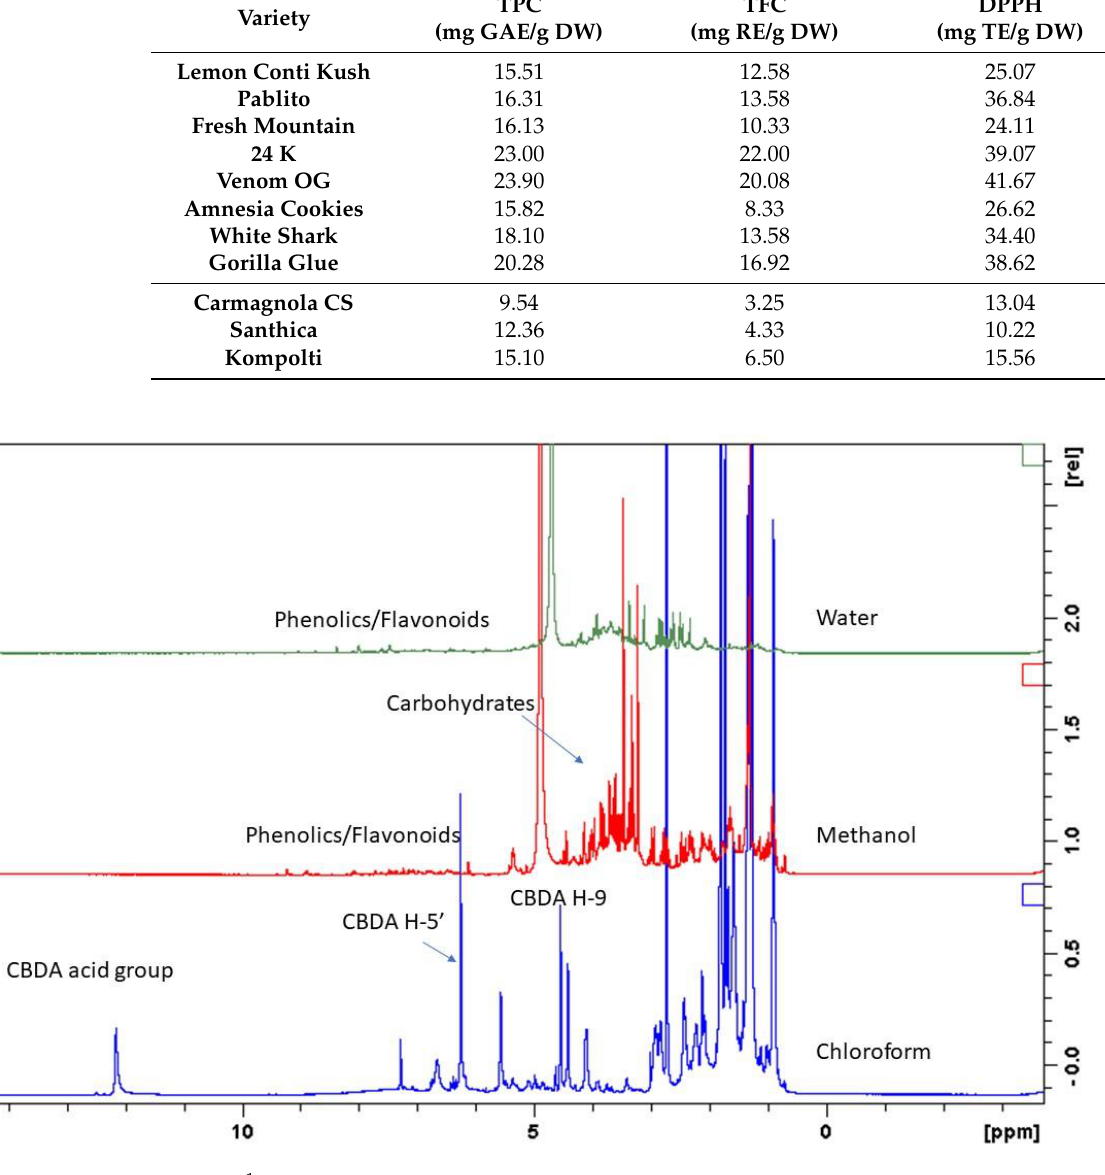
Figure 3. 1 H-NMR spectra showing the cannabinoids profiles of UM and DM chloroform extract.